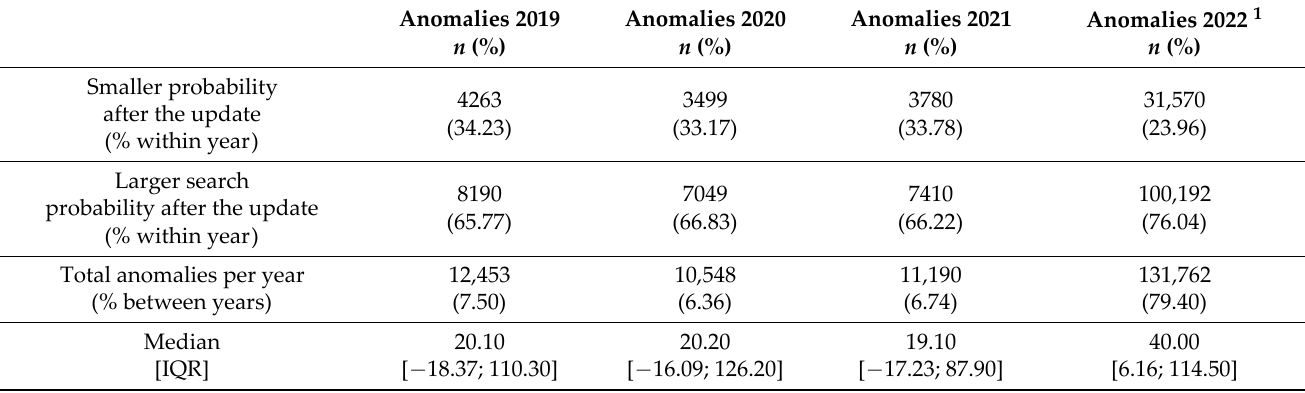
Table 2. Proportional distribution and basic descriptive summaries of anomalies detected in time series constructed from two retrievals of Google Trends API data; before and after the implemented change to the Google Sampling